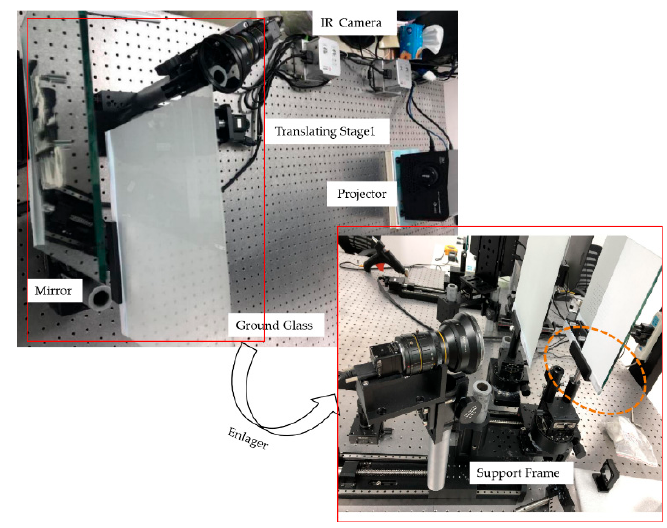
Figure 5. Hardware of the developed 3D measurement system.